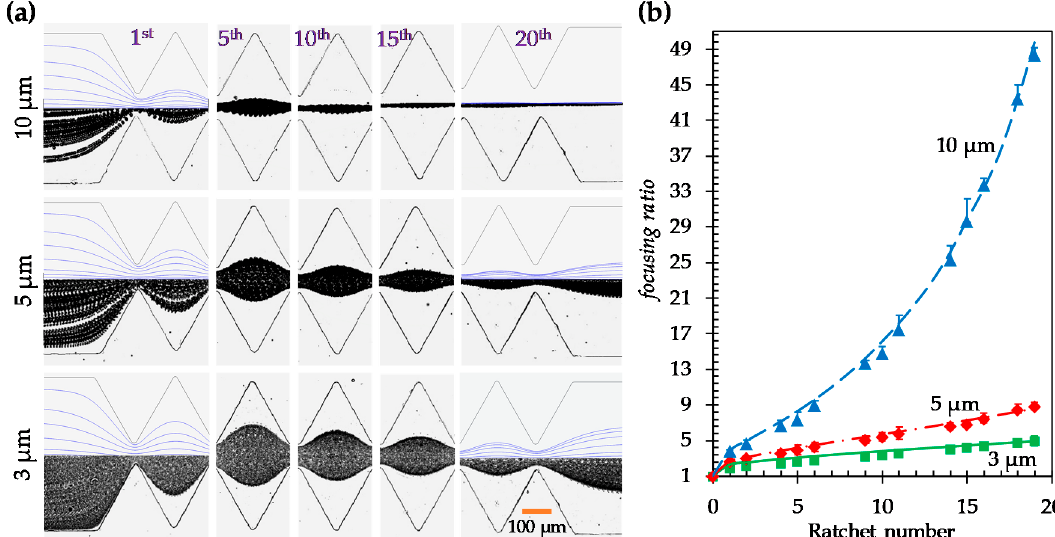
Figure 5. Effect of particle size on the dielectrophoretic focusing of polystyrene particles in the symmetric ratchet microchannel under a fixed DC electric field of 250 V/cm: ( a ) Comparison of the experimentally obtained and numerically predicted (top half of the left- and right-most images only) trajectories (traveling from left to right) of 3 (bottom row), 5 (middle row), and 10 μ m (top row) particles, respectively, at varying locations of the microchannel; ( b ) Comparison of the experimentally measured (symbols with error bars) and numerically calculated (curves) particle focusing ratios among the three types of particles.